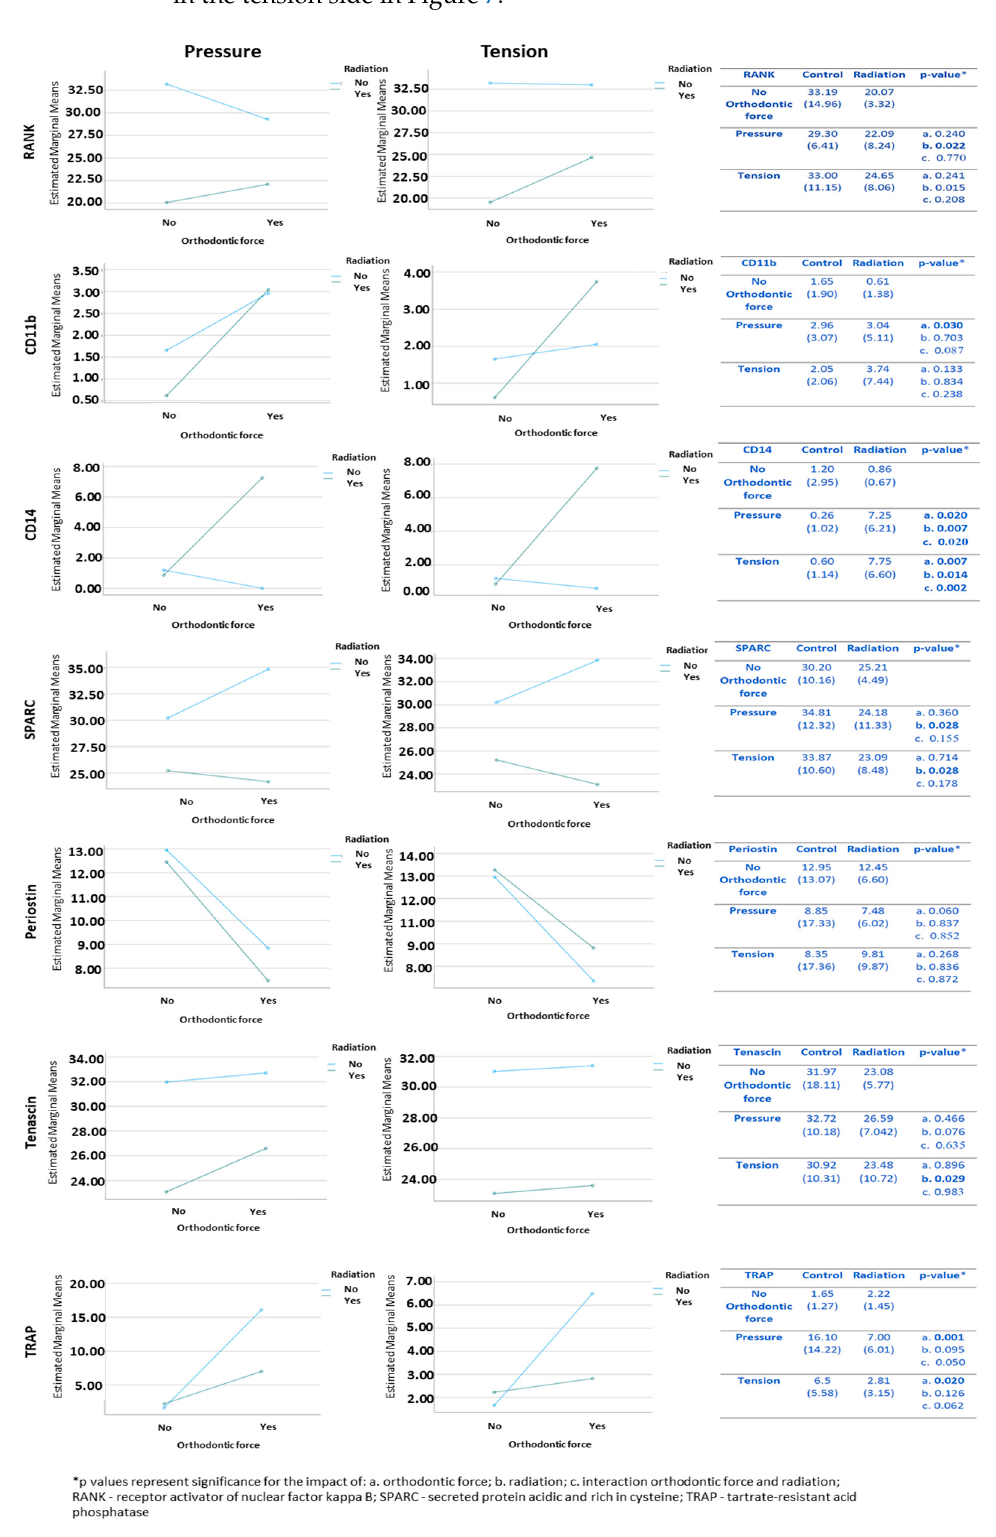
Figure 5. Changes in cells immuno-positive for pre-osteoclast markers (RANK, CD11b, CD14) and pre-osteoblast cells (SPARC, periostin, tenascin) as a factor of orthodontic force and